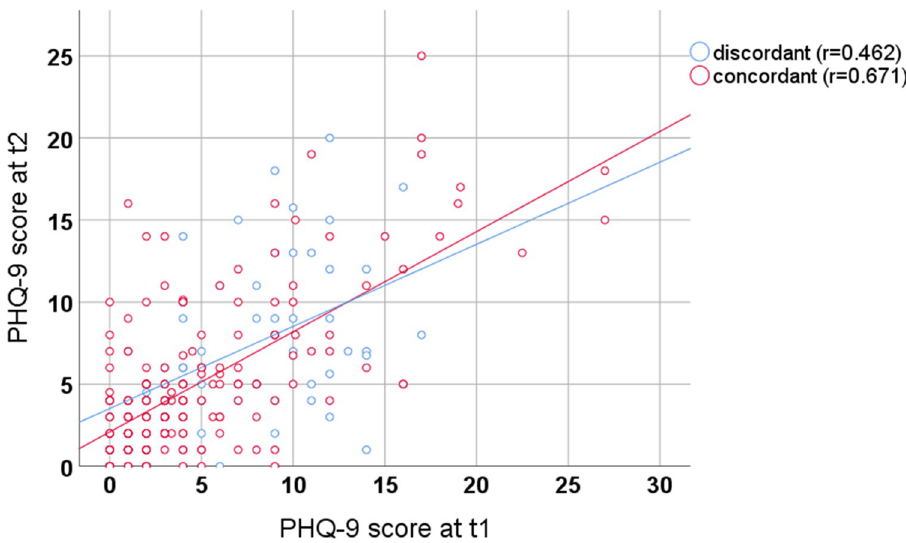
Fig 3. Correlation of PHQ-9 scores at t1 and t2 with discordant vs. concordant PHQ-9 and GP rating.